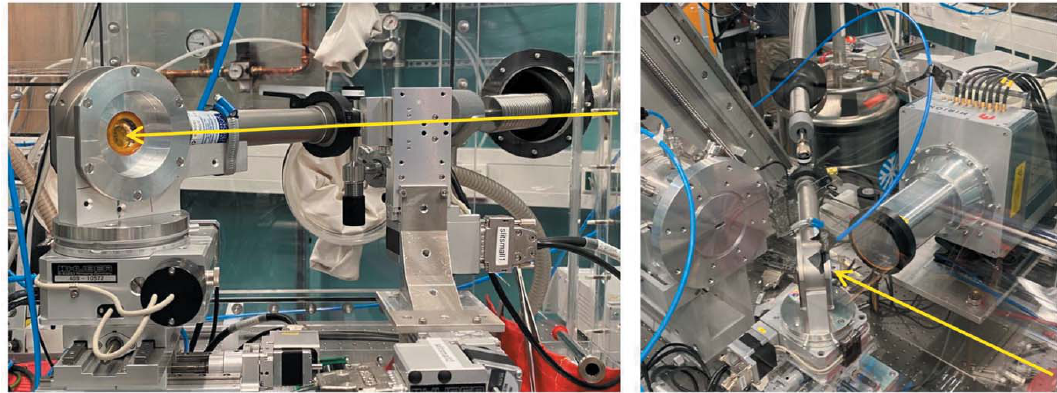
Figure 5 Left image – the cryostat vacuum chamber rigidly mounted on top of the sample positioning stage (analyzer-crystal point of view). The sample cell is visible through the outer KAPTON vacuum window. The arrow marks the incoming beam passing the auxiliary four-blade slit in front of the sample. Right image – the cryostat used inside the He box with opened lid for standard fluorescence XAFS detection mode. The arrow marks the incoming